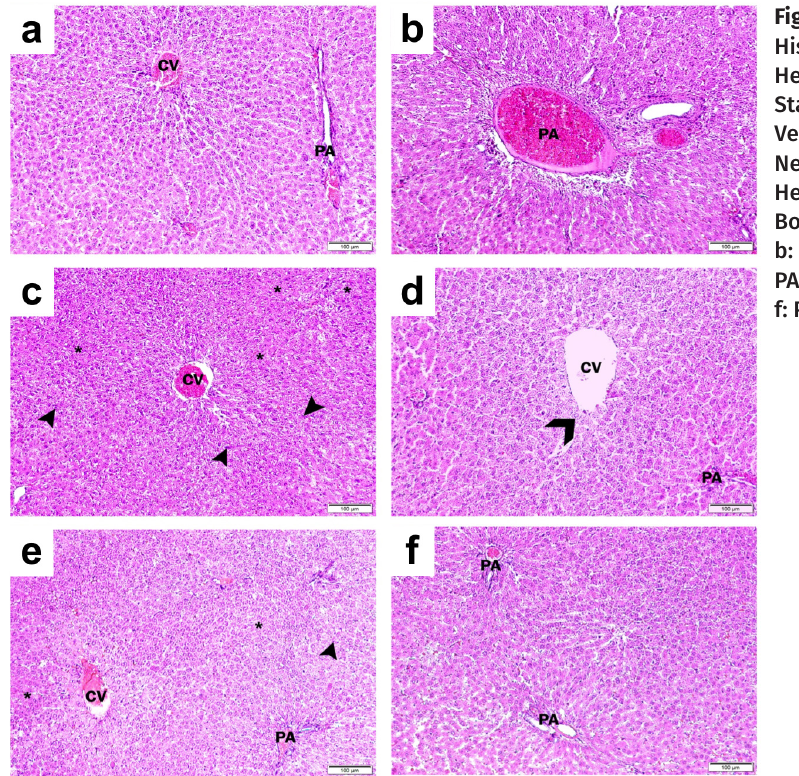
Figure 4. Results of Histopathological Hematoxylin-Eosin Staining of (CV: Central Vein, PA: Portal Area, *: Necrotic Areas, Arrow Heads: Apoptotic Bodies). a: Healthy, b: FIS50, c: PARA,